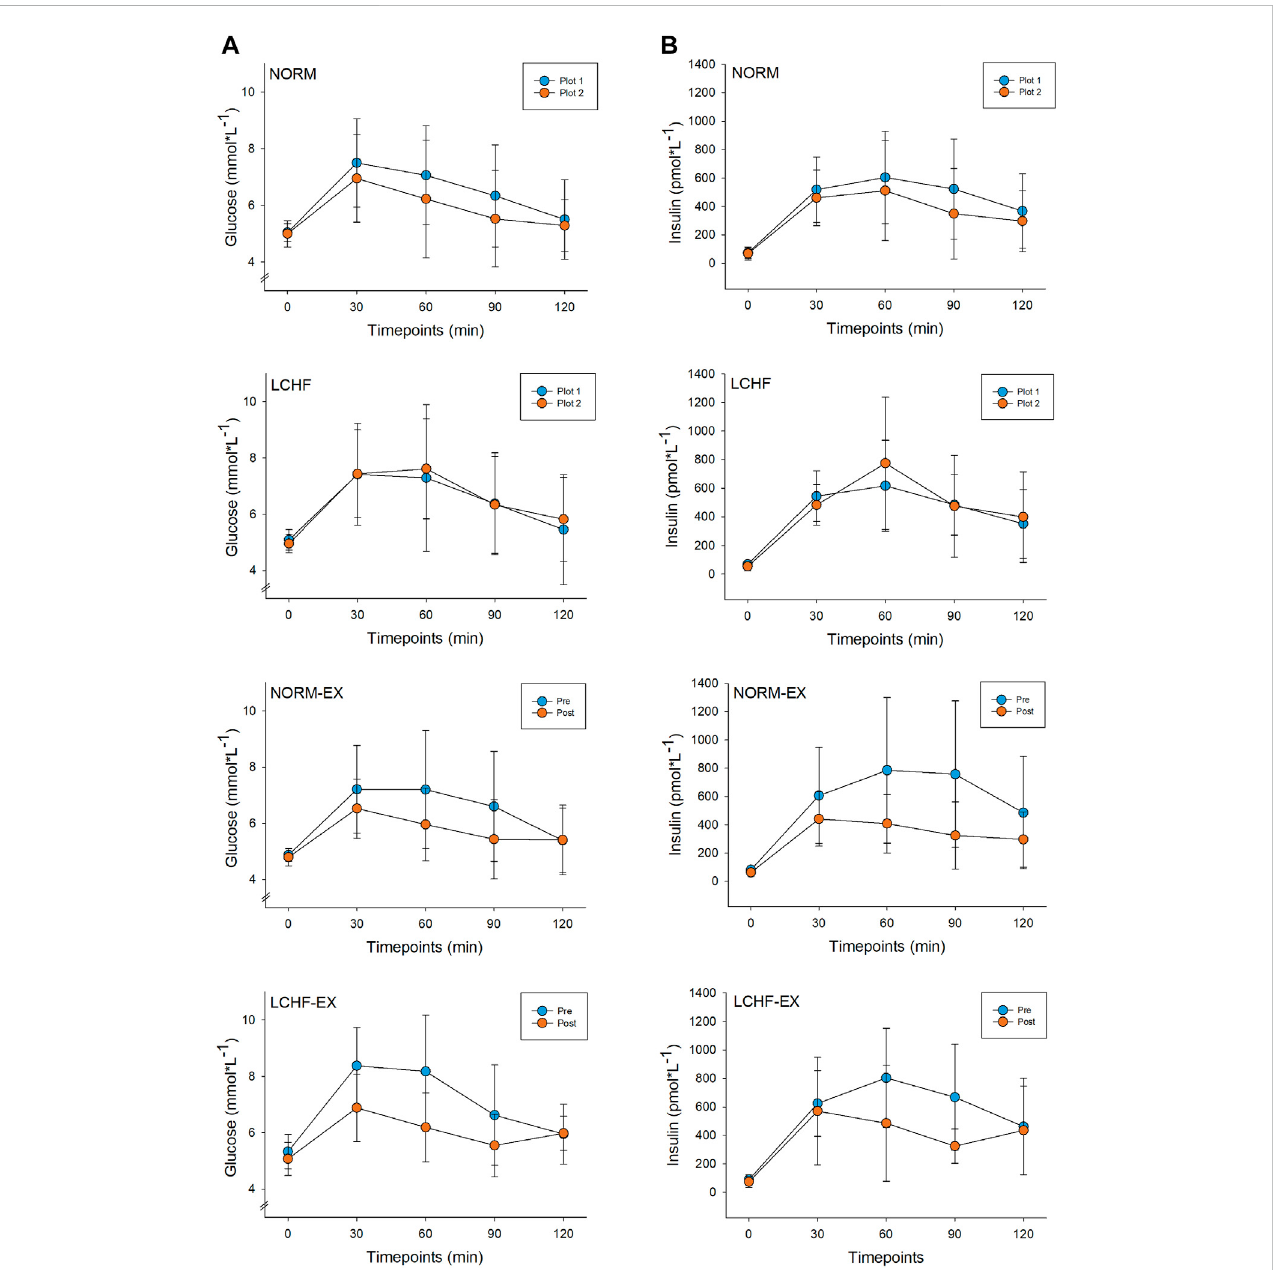
FIGURE 4 Time course prior to (pre) and after (post) the 10-week intervention for glucose (A) and insulin (B) during a 120-minute oral glucose tolerance test (OGTT). NORM, Normal diet; LCHF, Low-carbohydrate high-fat diet; NORM-EX, Normal diet combined with exercise; LCHF-EX, Low-carbohydrate high-fat diet combined with